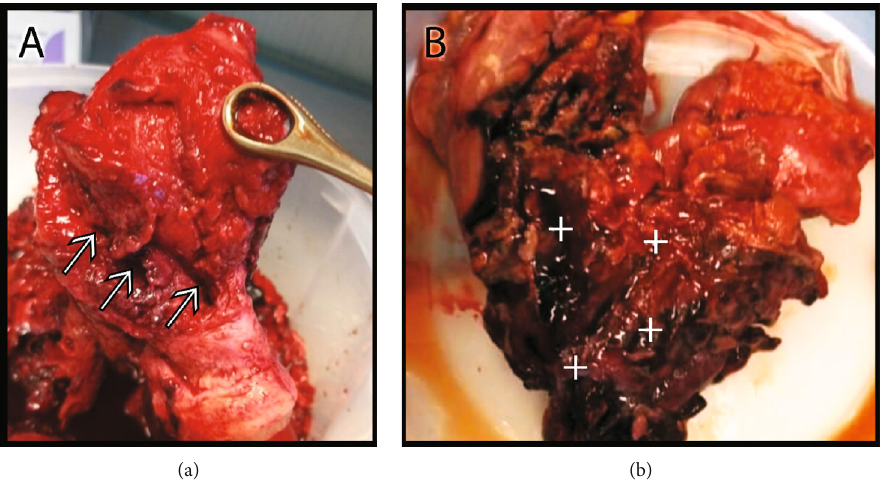
Figure 1: (a) The resected uterus. Note the large perforations on its right wall (white arrows). (b) The resected sigmoid colon with the placental insertion (+). Note the aggressive placental invasion of the sigmoid colon provoking severe